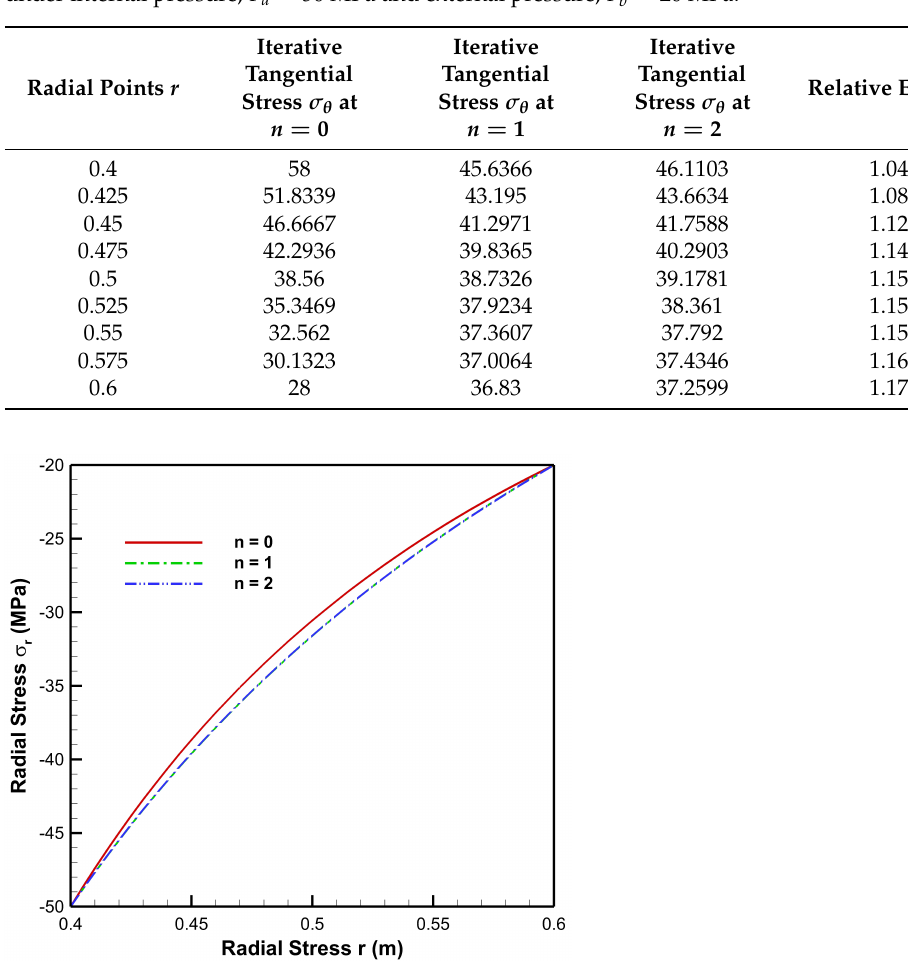
Table 6. Comparison of tangential stress σ θ in FGM cylinder at n = 0, n = 1 and n = 2 iterations under internal pressure, P a = 50 MPa and external pressure, P b = 20 MPa.